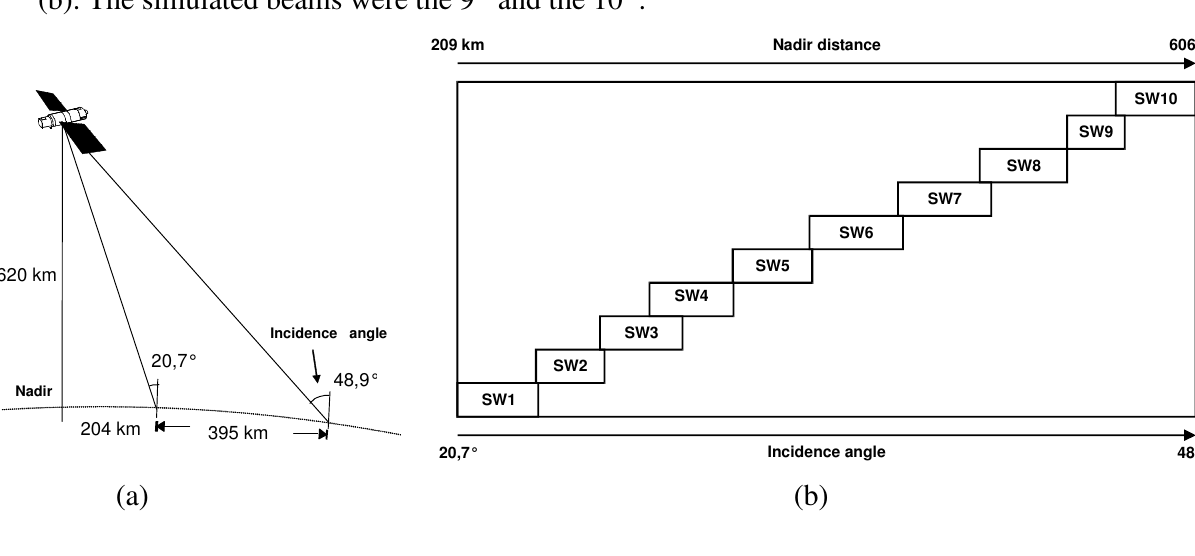
Figure 2. MAPSAR acquisition geometry (a) and beams for the Medium Resolution Mode (b). The simulated beams were the 9 th and the 10 th